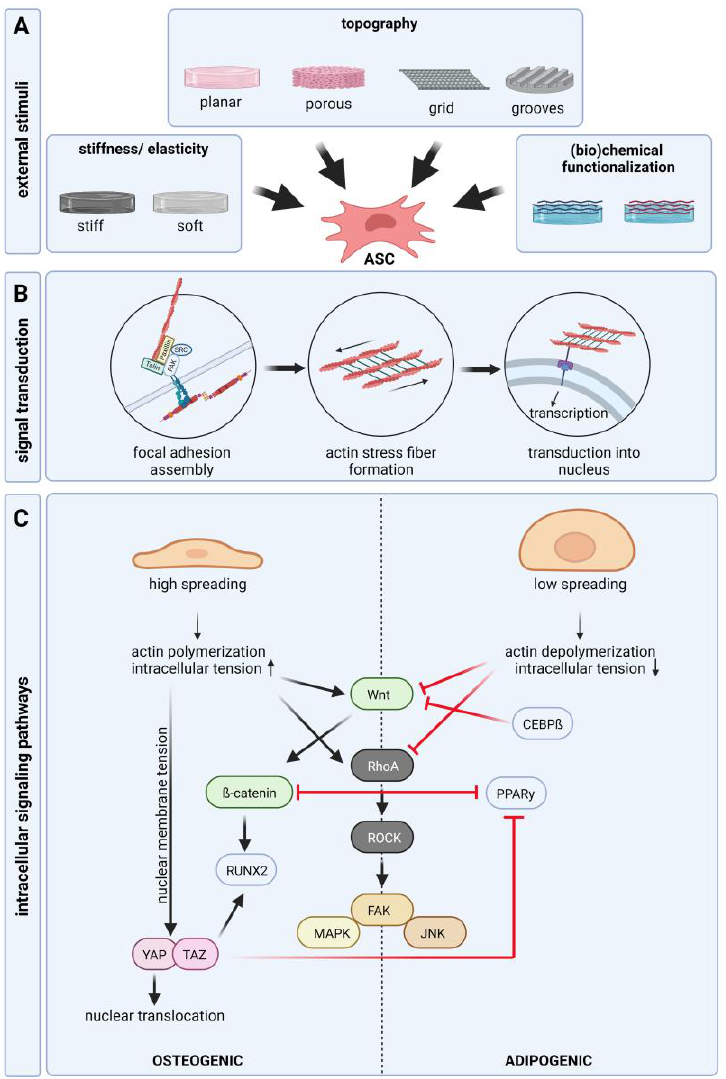
Figure 2. Impact of material properties on the ASC behavior and involved signaling pathways. ( A ): Material properties, such as stiffness/elasticity, pore size/porosity, topography/geometry, and (bio)chemical functionalization (and subsequent protein adsorption) have a strong impact on ASC behavior by influencing cytoskeletal reorganization, integrin expression, and focal adhesion assembly. ( B ): Focal adhesion assembly that is induced by ECM interaction is transduced into the nucleus via stress fiber formation and their interaction with the nuclear membrane. Signal transduction into the nucleus impacts the activity of transcription factors, histone modification, epigenetics, and chromosome condensation. ( C ): Enhanced spreading of the cell leads to actin polymerization and an increase of intracellular tension and subsequent activation of osteoinductive signaling pathways Wnt/β -catenin, RhoA/ROCK, and YAP/TAZ. In contrast, reduced spreading leads to decreased intracellular tension and inhibition of osteoinductive signaling pathways which leads to adipogenic differentiation (created with BioRender.com).